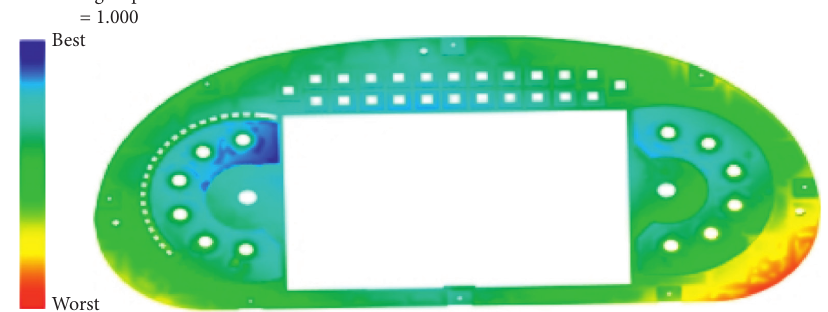
Figure 2: Cloud chart of optimal gate matching.